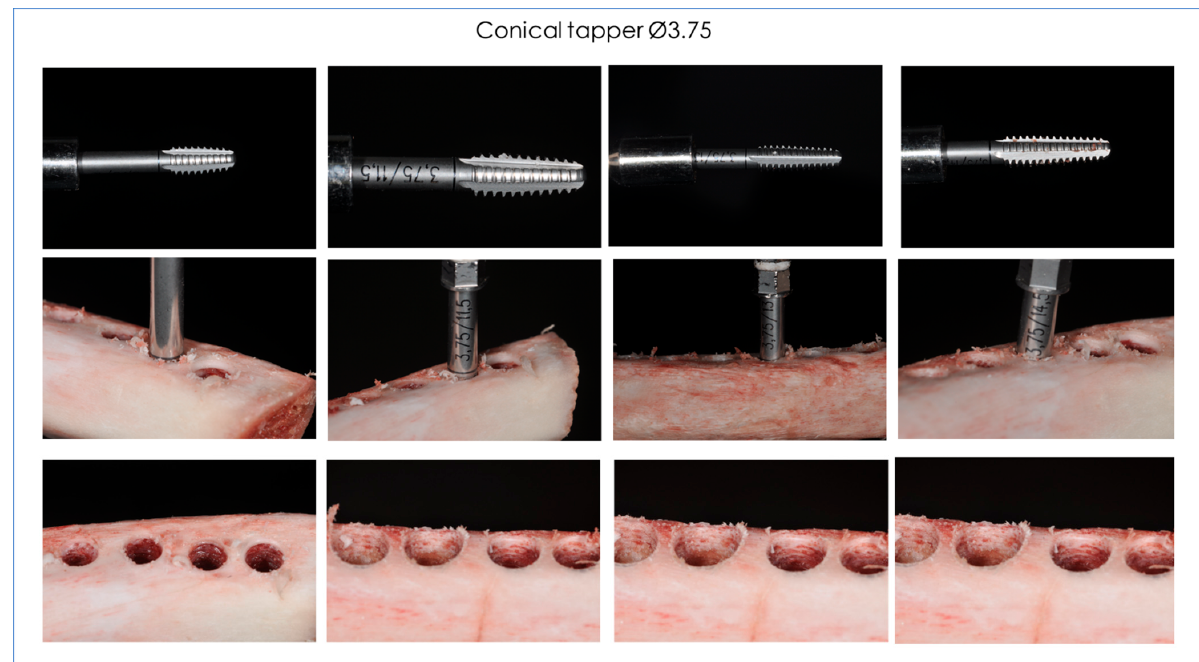
Figure 5. Details of the conical tappers preparation .